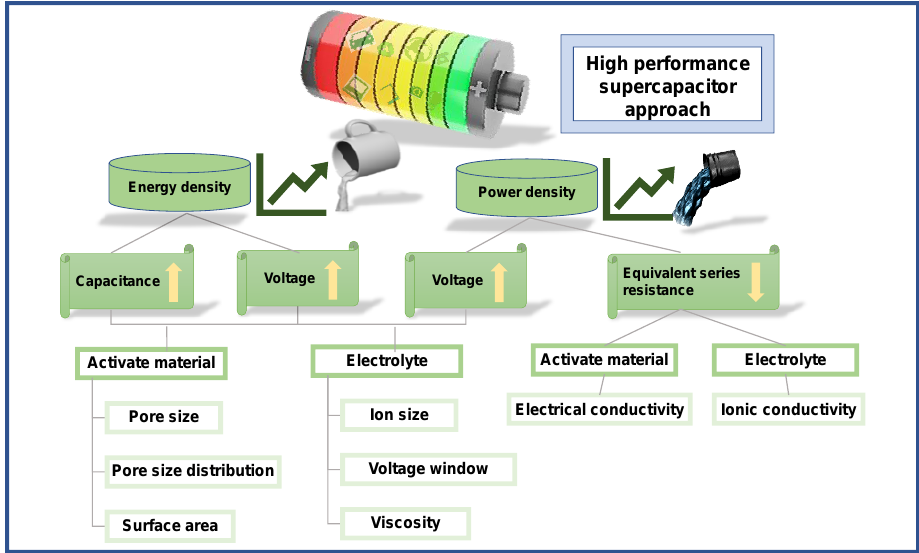
Figure 13. Schematic of a multifaceted approach to obtain high-performance supercapacitors.